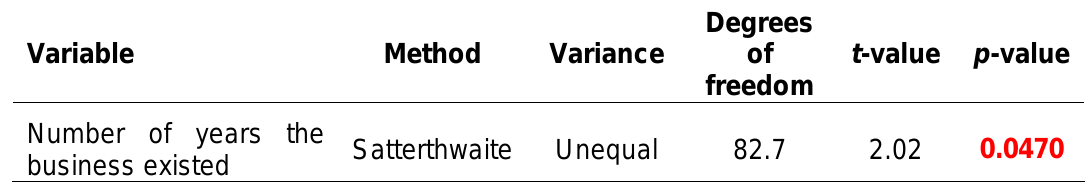
Table 5: Significant Differences Relating to Number of Years Business Existed